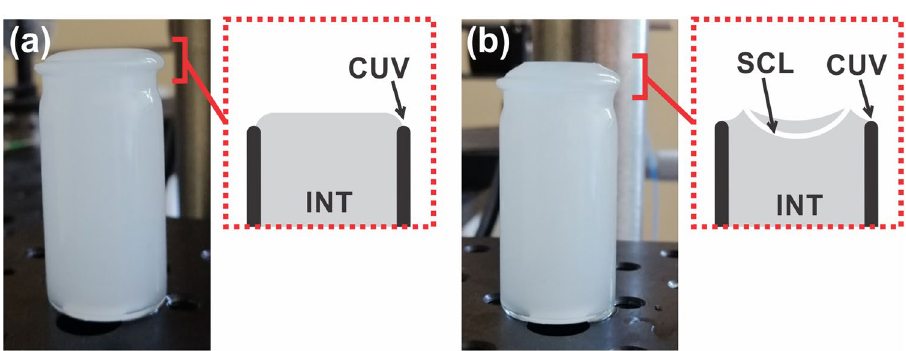
Figure 1. Contact lens measurement with SS-OCT. ( a ) Initial concave meniscus in the wet cell and ( b ) SCL on the concave meniscus. INT intralipid solution, CUV cuvette wall, SCL soft contact lens.